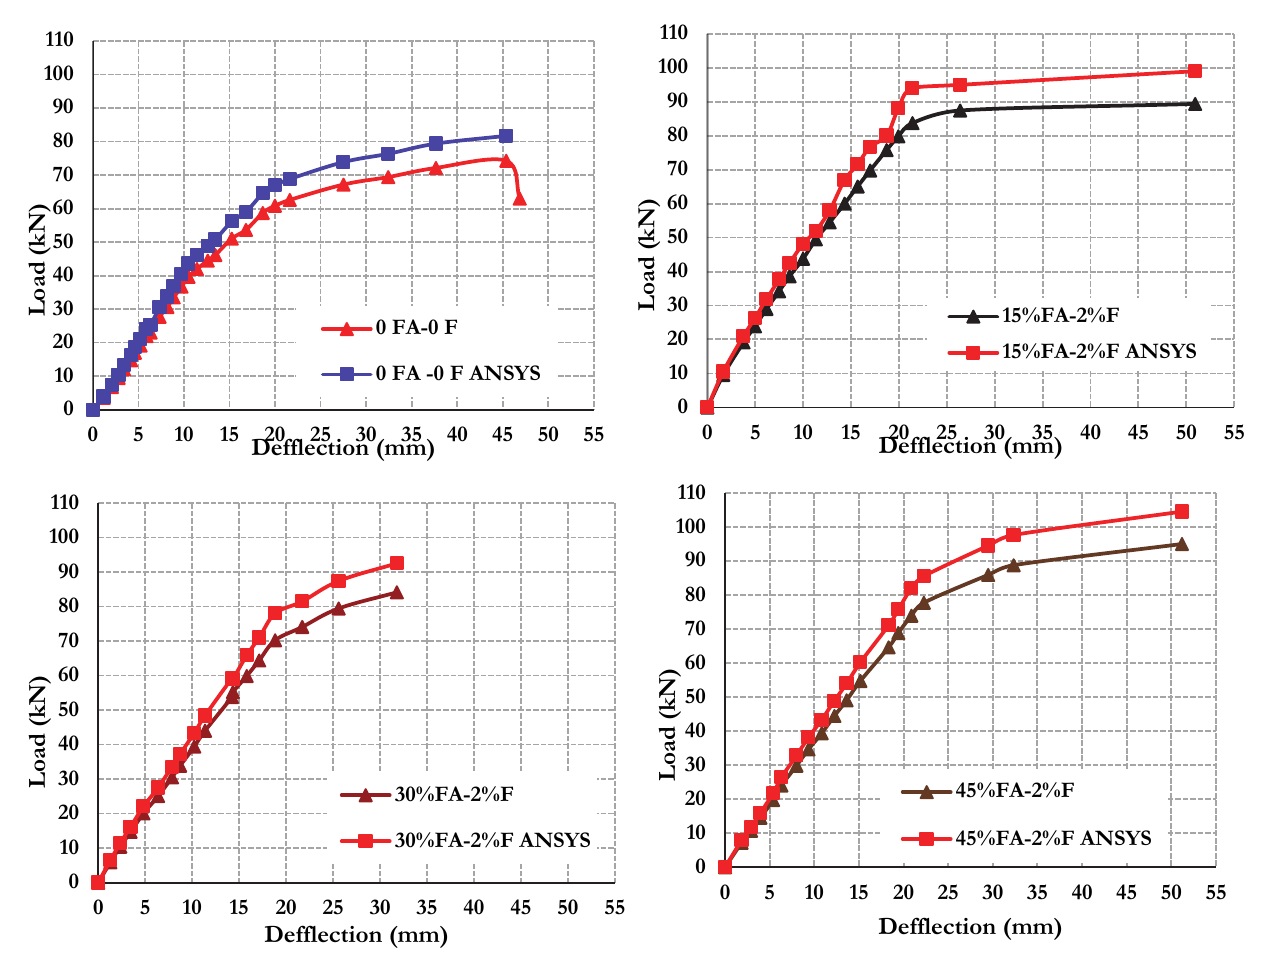
Figure 18: Experimental versus finite element backbone carve at 2% steel fibers.